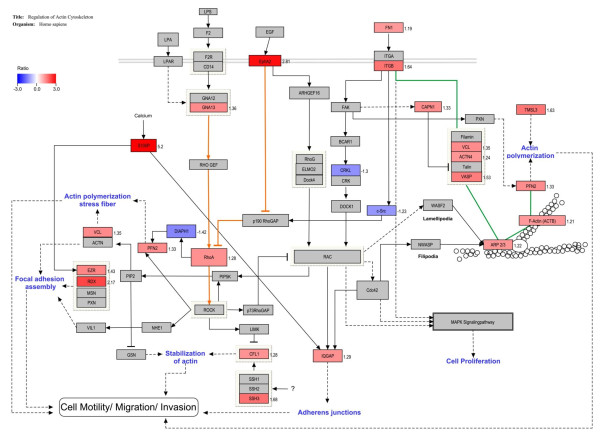
Regulation of actin cytoskeleton in the tamoxifen resistant cell line, MCF-7-TamR. The pathway illustrates changes to proteins expression, TamR cell line vs. control, involved in regulating the actin cytoskeleton. All red proteins are significantly up-regulated and all blue proteins are significantly down-regulated. The ratio value for each significantly regulated protein is indicated to the right. Solid lines with no arrow indicate physical interaction. Solid lines with an arrow or bar at the end indicate direct activation or inhibition, respectively. Dotted lines indicate indirect or unknown method of interaction. The orange lines highlight the Rho activation pathways and the green lines highlight integrin mediated focal adhesions.